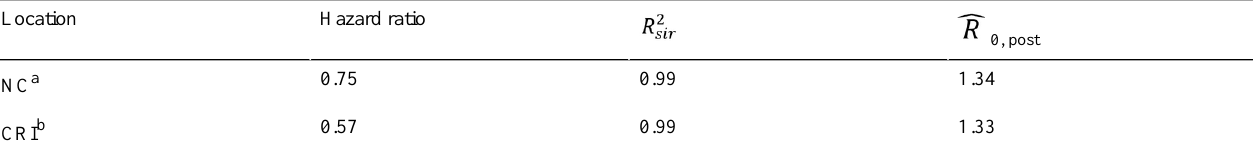
Table 2. Summary table of model fit for susceptible-infected-removed–int model in NC and the CRI. Hazard ratioLocation